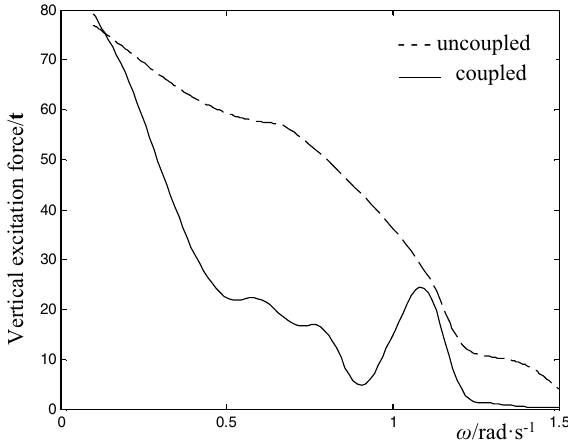
Fig. 8 Influence of wave frequency on the vertical force for the fifth pontoon ( 𝛽 = 22.5 ◦ )